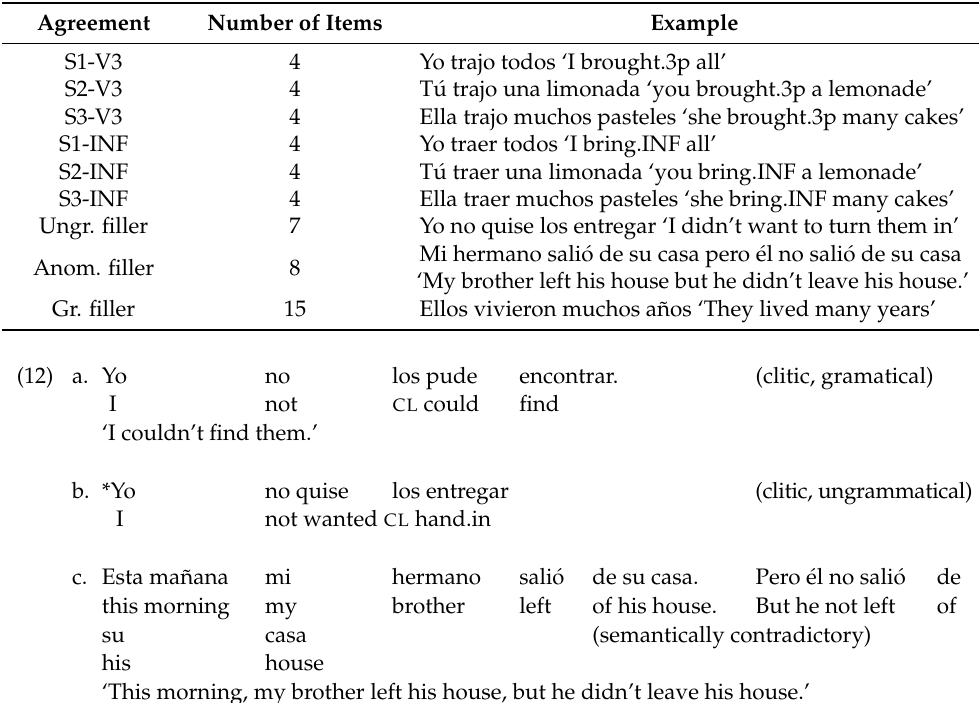
Table 5. Experimental